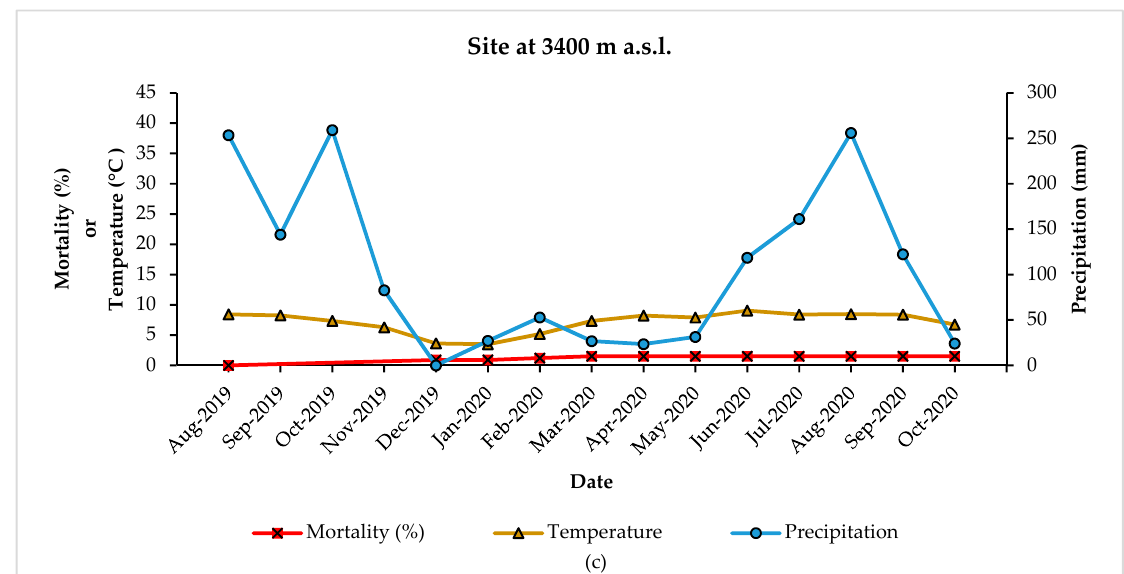
Figure 4. Mortality (%), monthly mean temperature ( ◦ C) and monthly precipitation (mm) in the period August 2019 to October 2020, for each test site, at ( a ) 2400 m a.s.l., ( b ) 3000 m a.s.l. and ( c ) 3400 m a.s.l.